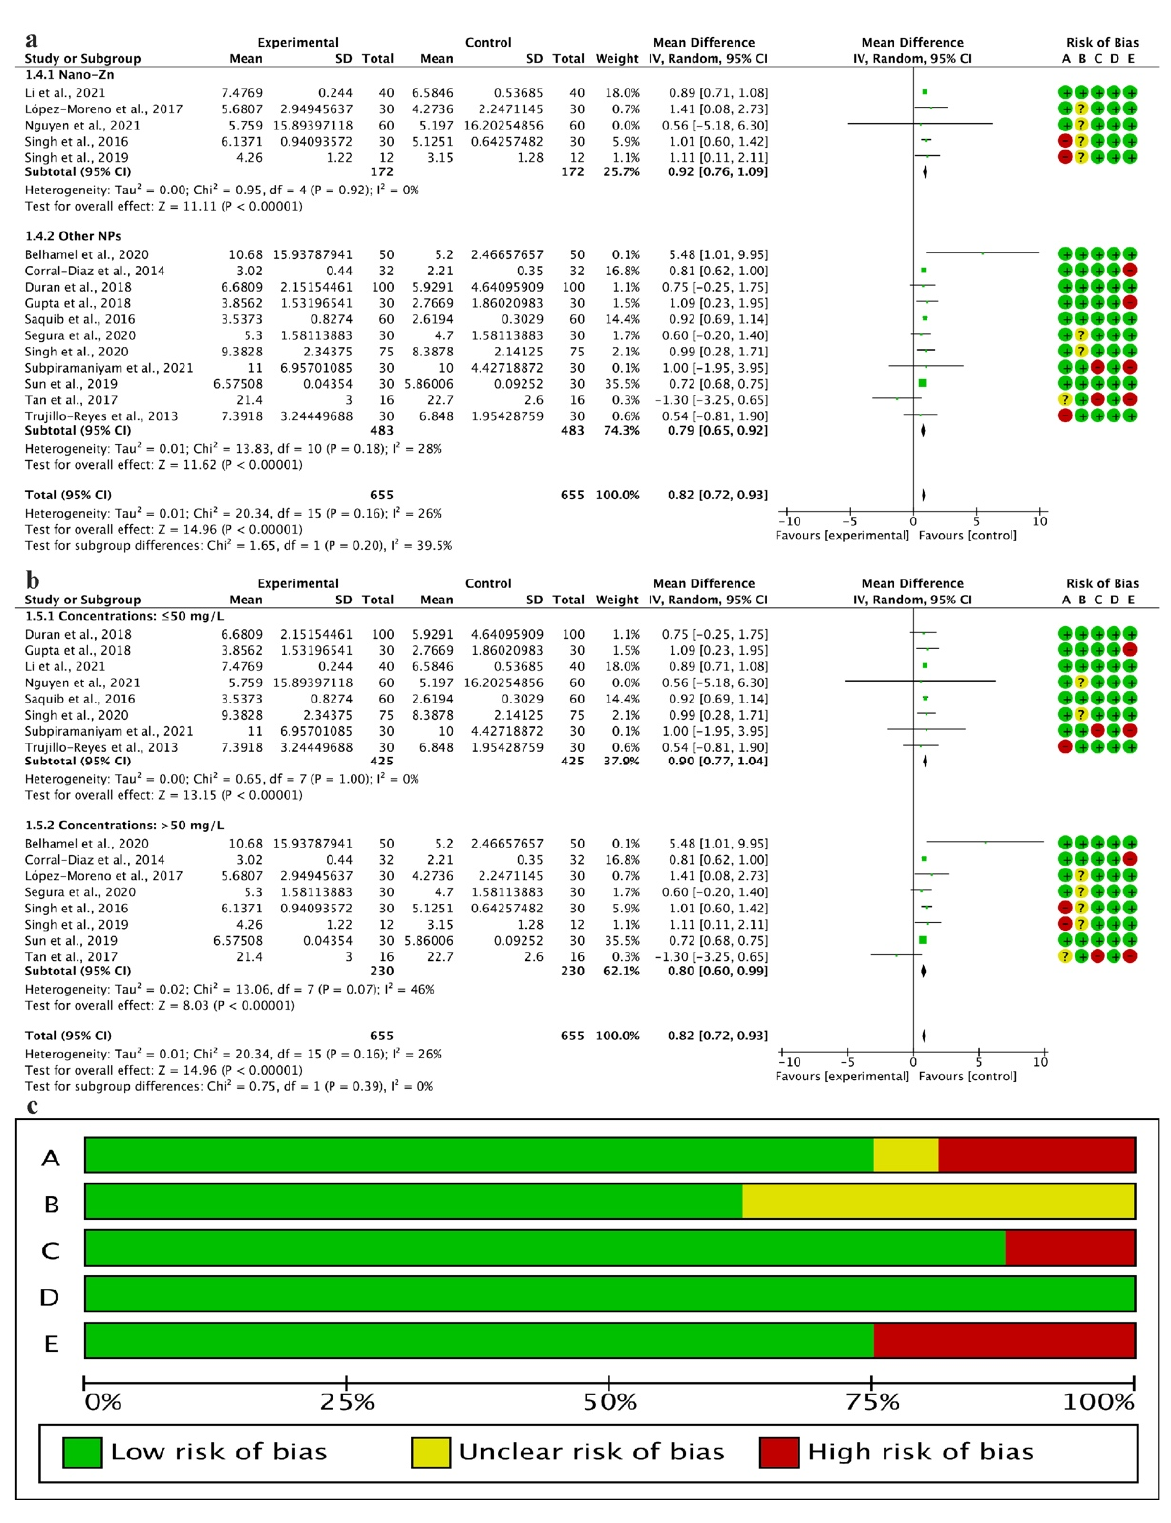
Figure 5. Heterogeneity evaluation, subgroup analysis, and risk of bias assessment for RL. ( a ) Sub- group analysis for NP types; ( b ) subgroup analysis for NP concentrations; ( c ) risk of bias assessment.